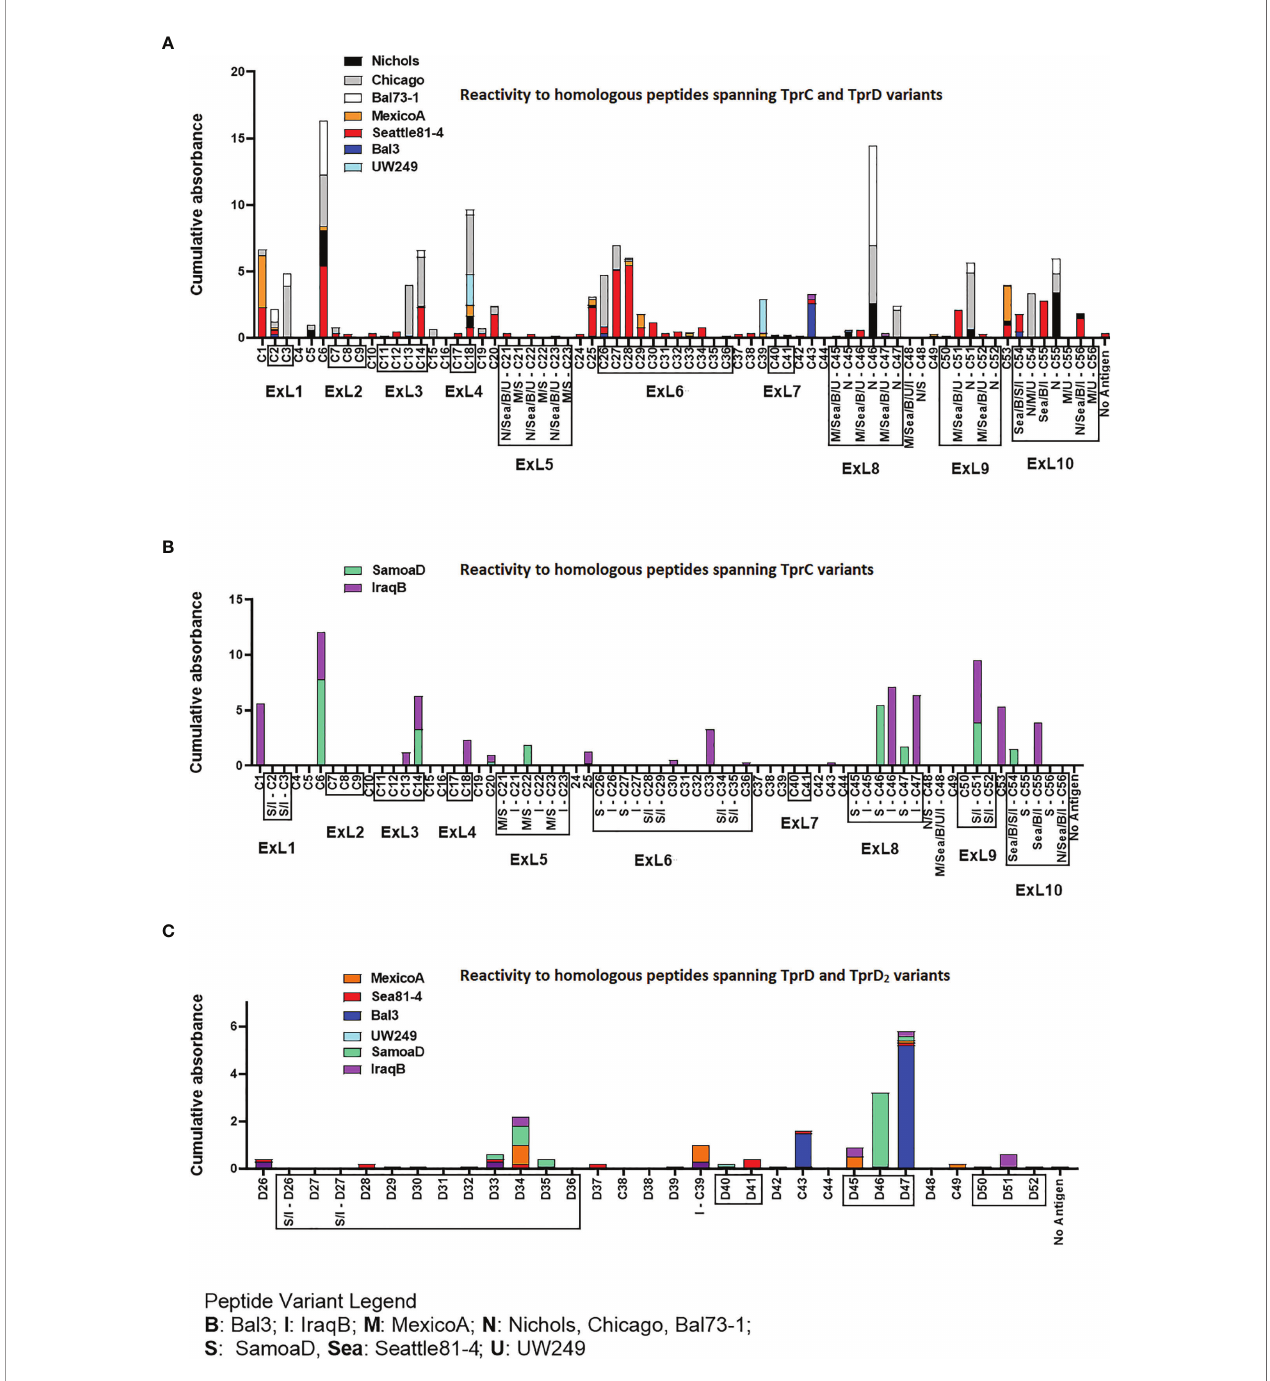
FIGURE 3 | Reactivity of sera from experimentally infected animals to homologous peptides representing the TprC, TprD and TprD 2 variants. (A) Reactivity to homologous peptides spanning TprC and TprD proteins of sera from rabbits infected with Tp subsp. pallidum (Nichols, Chicago, Bal73-1, MexicoA, Sea81-4, Bal3, and UW249B) collected at day 30, 60, and 90 post-infection. Nichols, Chicago, and Bal73-1 sequences are identical. (B) Reactivity to homologous peptides spanning TprC variants of immune sera from groups of rabbits infected with Tp subsp. pertenue (SamoaD) or Tp subsp. endemicum (IraqB) strains collected at day 30, 60, and 90 post-infection. (C) Reactivity to homologous peptides spanning TprD and TprD 2 variants of sera collected at day 30, 60, and 90 post-infection from all TprD 2 -containing Tp subspecies and strains studied here. Cumulative Absorbance values are the sum of the mean OD values obtained from all animals in the infection group at all three time points. Boxed peptides contain at least seven amino acids (35% of the peptide length) belonging to a predicted ExL. Strain names on x axis are abbreviated as follows: N, Nichols; M, MexicoA; Sea, Sea81-4; B, Bal3; U, UW249; S, SamoaD; I,